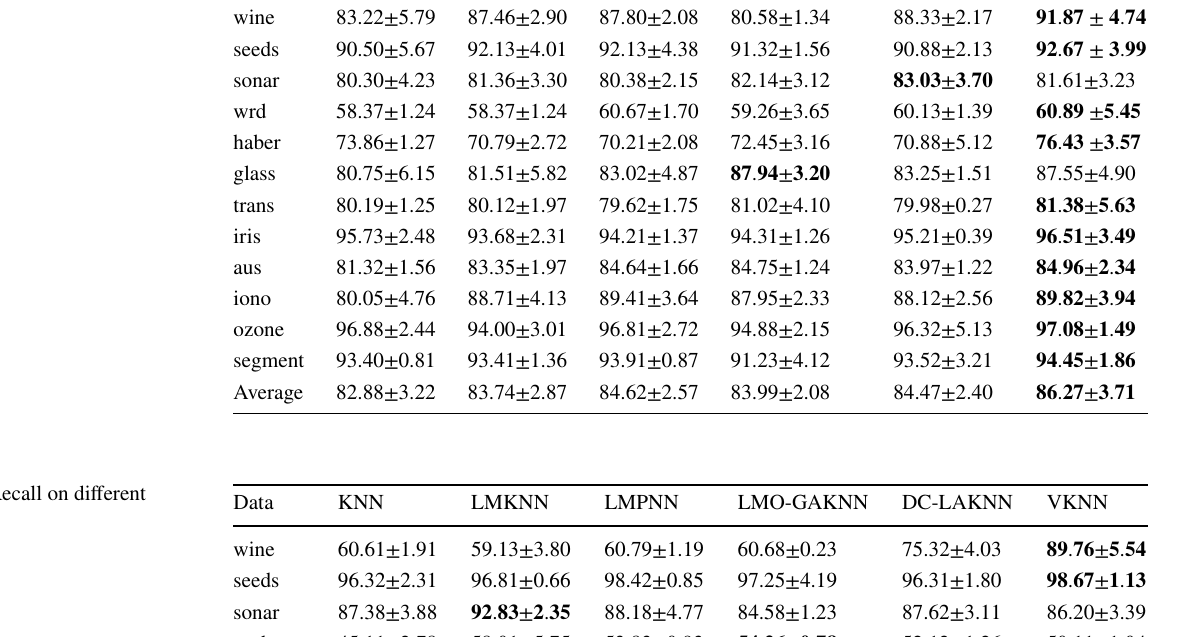
Table 2 Accuracy on different datasets